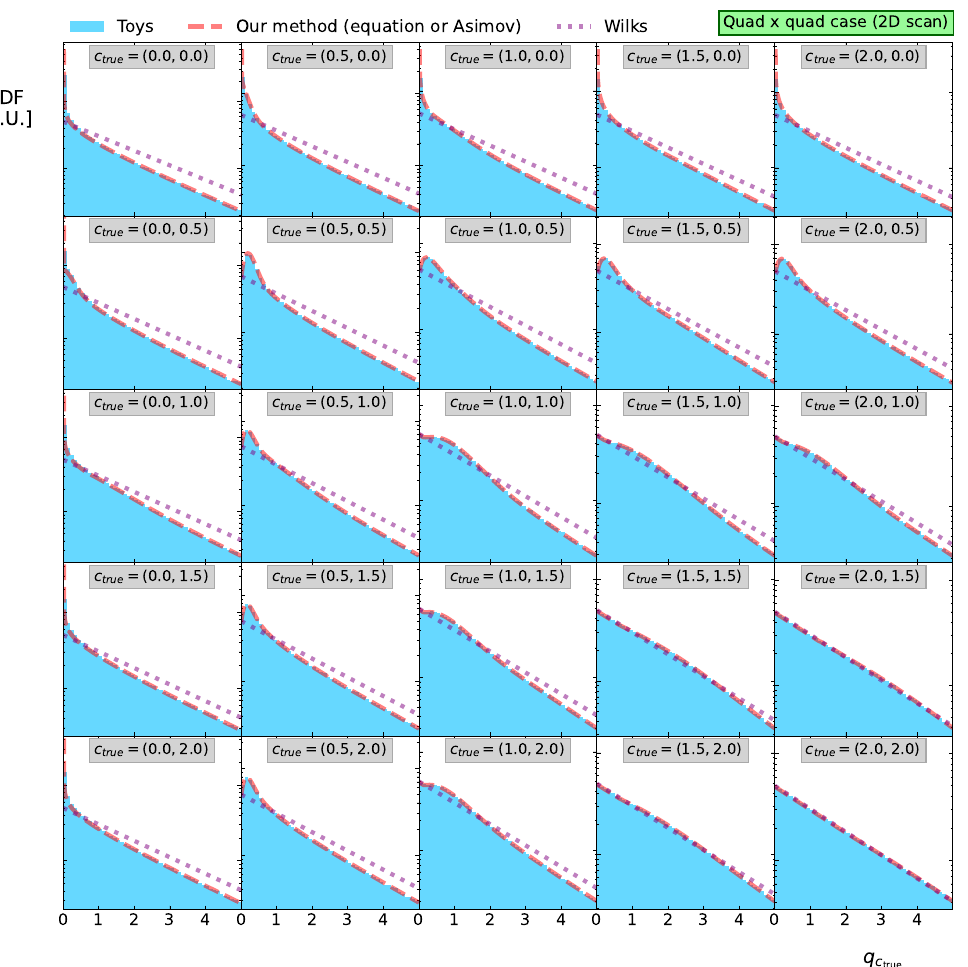
Figure 8: Density of pseudo-experiments compared with our method for a 2D ex- = ( − 0.5,0.3 ) , ¯ n = ( 0.8,0.1 ) and a strong negative correlation of ample with ¯ n 1 2 ρ = − 0.79. Our method is able to describe cases with c ∼ ( 0,0 ) where Wilks’ true theorem is violated.